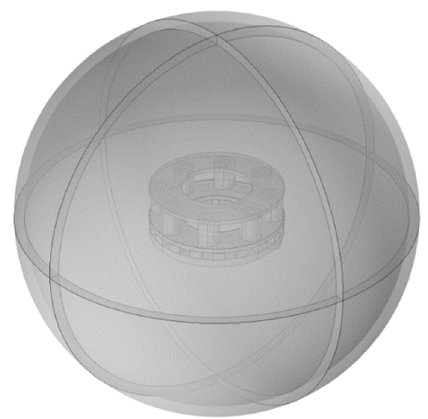
Figure 3. Computational domain of the integrated brake model.